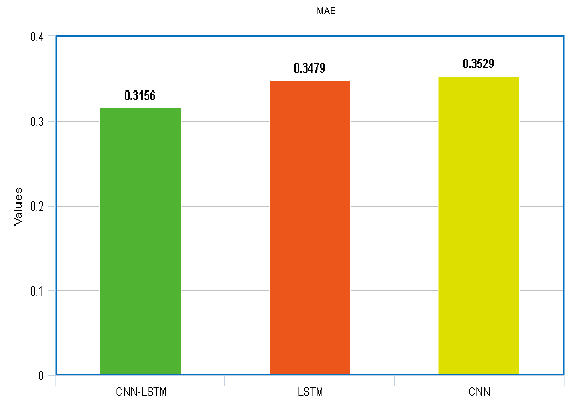
Figure 15. MAE comparison on ITC In the Figures 10-15, the MAE values of CNN-LSTM, LSTM and CNN are calculated and their bar graphs have been plotted of the stock datasets. It is observed that CNN has the highest MAE values while CNN-LSTM has the lowest MAE values. Thus, this concludes that the CNN- LSTM Hybrid Model has the most smaller MAE values among the three